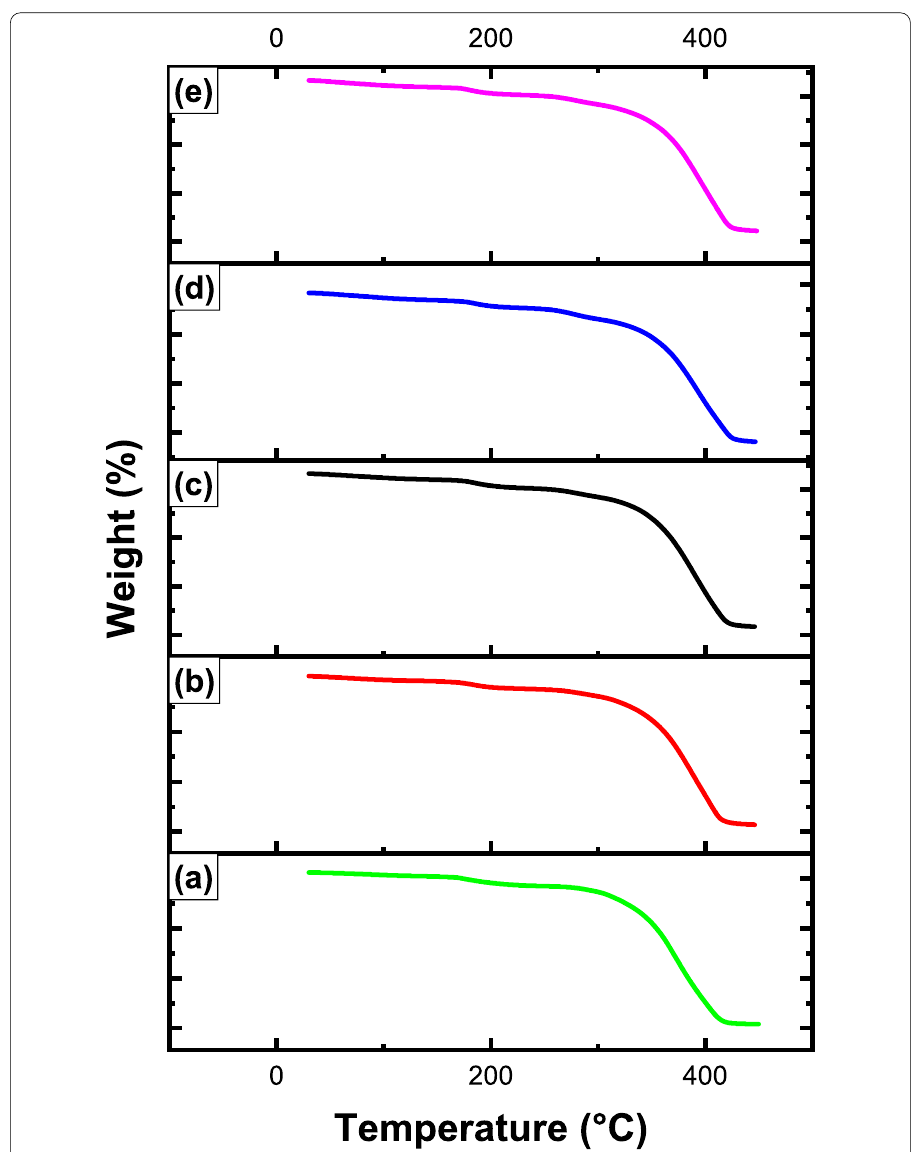
Fig. 4 Thermogravimetric scans of a TF-NC0, b TF-NC5, c TF-NC10, d TF-NC15, and e TF-NC20